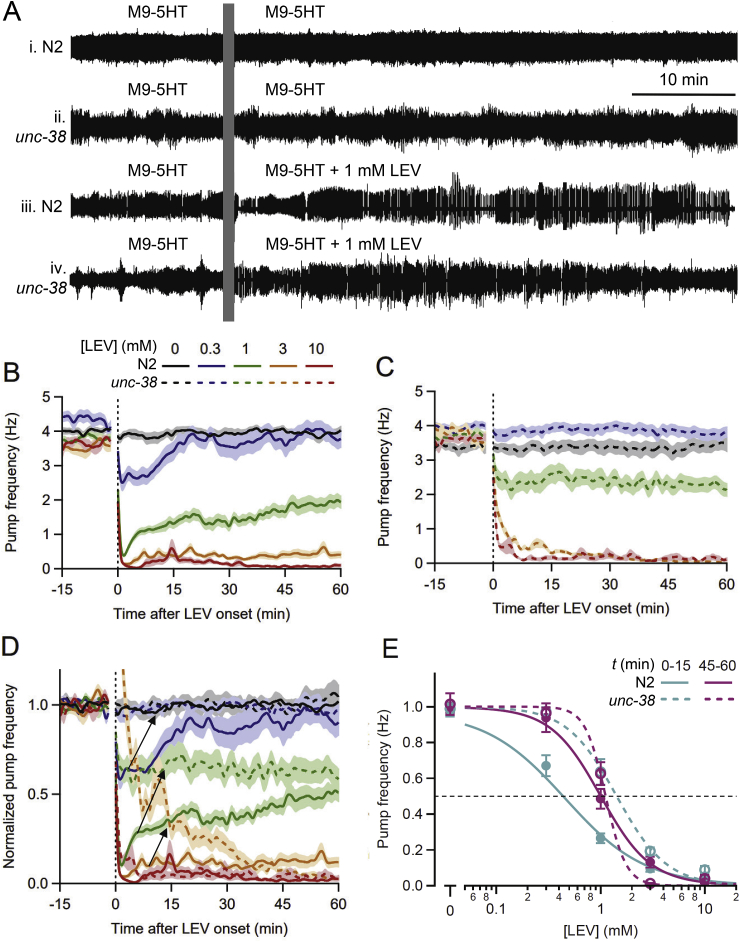
unc-38 (LEV-resistant) worms are less sensitive to LEV than N2s. A. Representative EPG recordings from individual worms, all perfused with M9-5HT during the baseline period. i, ii, N2 and unc-38 worms switched to M9-5HT (controls); iii, iv, N2 and unc-38 worms switched to 1 mM LEV in M9-5HT. LEV inhibited pumping more strongly in N2 than in unc-38. B, C. Pump frequency plotted over time for N2 (B) and unc-38 (C) worms switched at t = 0 min to different concentrations of LEV (mean ± S.E.M., n = 16–32 worms/group). In all panels, concentrations are denoted by color and genotype by line type (solid, N2; dashed, unc-38). Perfusate switch occurred at the vertical dotted line, with the electrical artifact blanked. LEV caused concentration-dependent inhibition of pumping in both strains. D. Same data as in B and C, displayed together after normalizing pump frequency. N2s showed an early phase of inhibition compared to unc-38 worms; arrows denote reduced inhibition in unc-38 compared to N2 worms at 0.3, 1 and 3 mM LEV. E. Same data, fitted to the Hill equation for post-switch interval t = 0–15 min (“rapid” inhibition; teal lines) and t = 45–60 min (“sustained” inhibition; pink lines). Dashed line denotes EC50 (LEV concentration at which pump frequency was reduced by half). EC50 values (mean ± S.E.M.) for LEV were: N2 rapid, 0.46 ± 0.06 μM; N2 sustained, 1.00 ± 0.12 μM; unc-38 rapid, 1.38 ± 0.15 μM; unc-38 sustained, 1.14 ± 0.07 μM. Statistical comparisons are provided in Section 3.6. (For interpretation of the references to color in this figure legend, the reader is referred to the Web version of this article.)